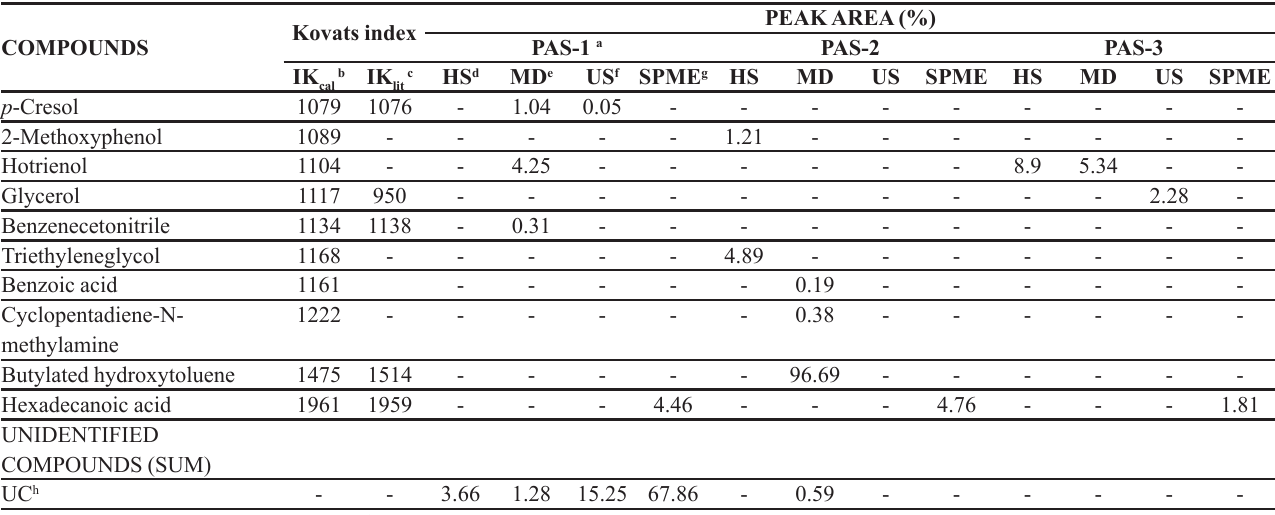
a PAS - volatile oil in stingless bee pollen; b IK cal - calculated Kovats index of substances detected; c IK lit - index of Kovats found in the literature of the substances detected; d HS – extraction by headspace; e MD - extraction by mycrohydrodistillation; f US - extraction assisted by ultrasound; g SPME - extraction by solid phase microextraction; h UC - unidentified compounds; (*) - Nineteen substances most frequently among all the substances identified.